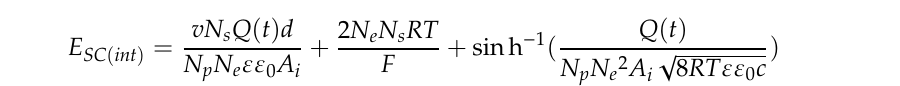
Figure 7. Flywheel model.